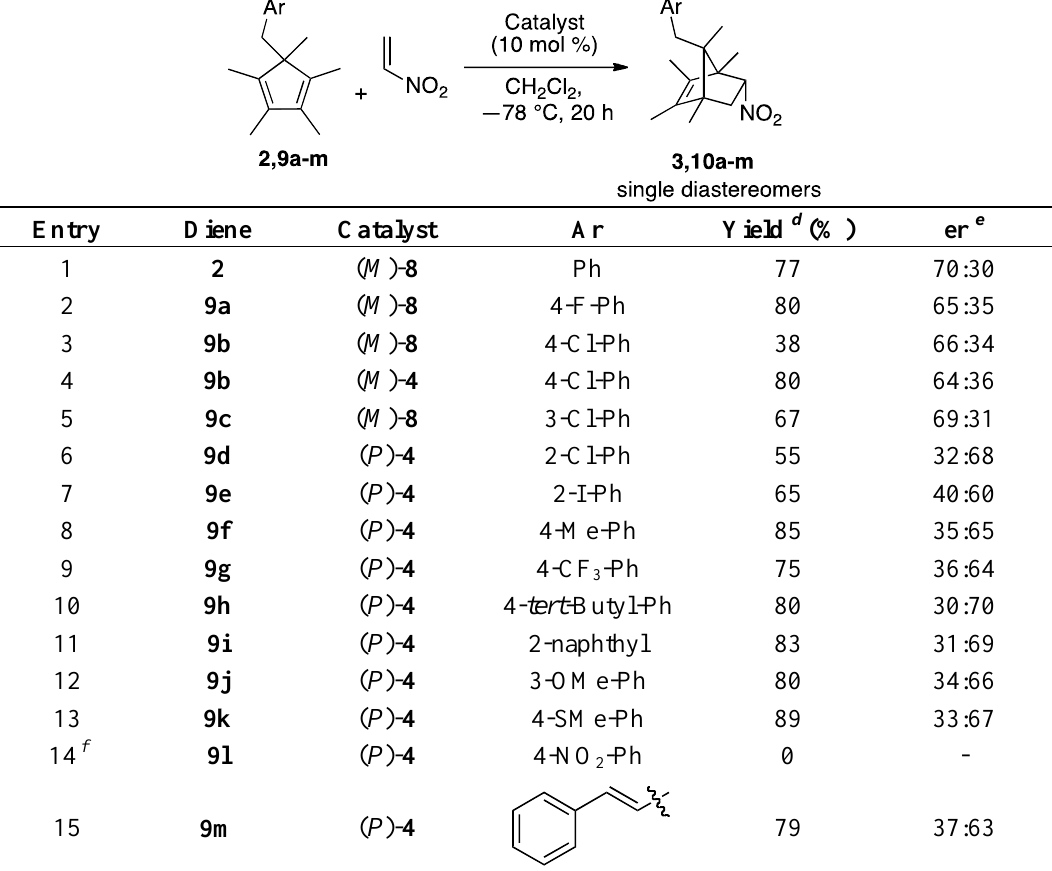
Table 2. Nitroalkene Diels-Alder reaction with different dienes a , b,c